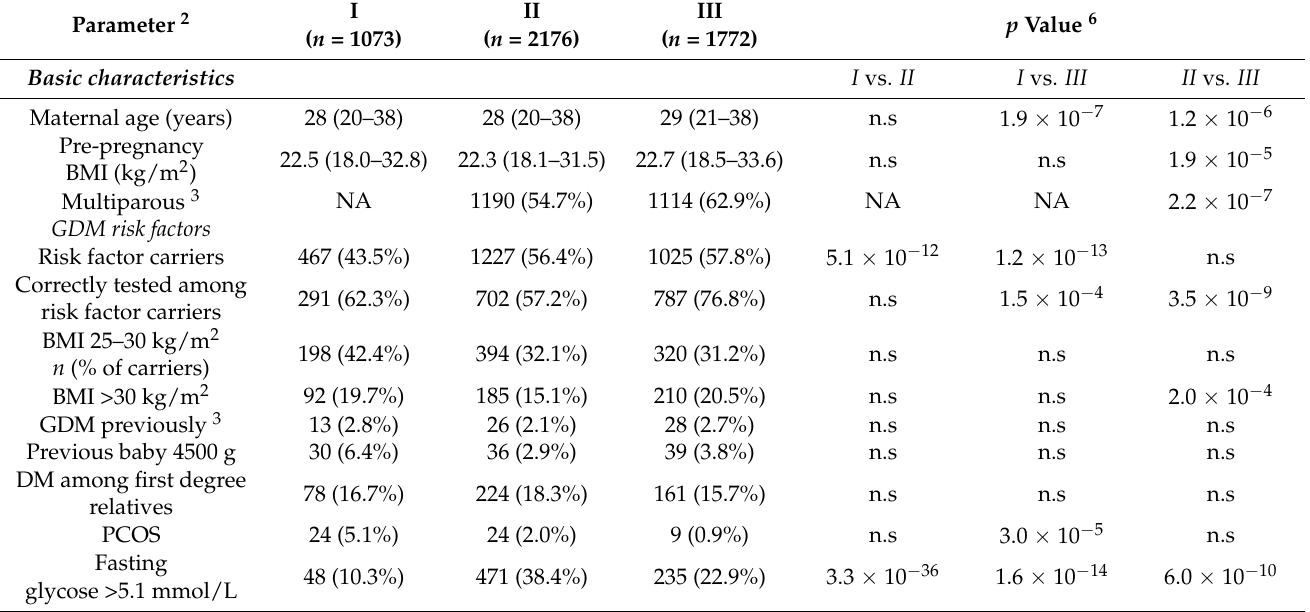
Table 1. Maternal characteristics of three datasets 1